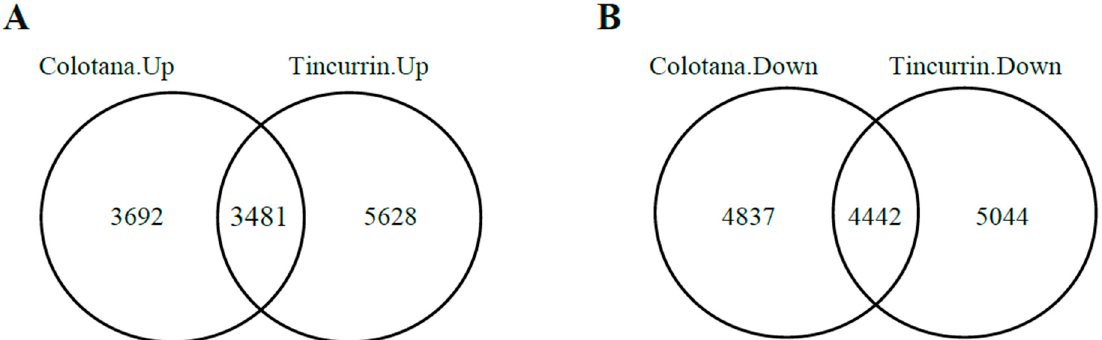
Figure 1. Venn diagram analysis of up- and downregulated genes ( A ) PEG-induced water-stress condition (Colotana.PEG) vs. Colotana under the control condition (Colotana.con) upregulated relative to PEG-induced water-stress condition (Tincurrin.PEG) vs. Tincurrin under control condition (Tincurrin.con) upregulated; ( B ) Colotana.PEG vs. Colotana.con downregulated relative to Tincurrin.PEG vs. Tincurrin.con downregulated.